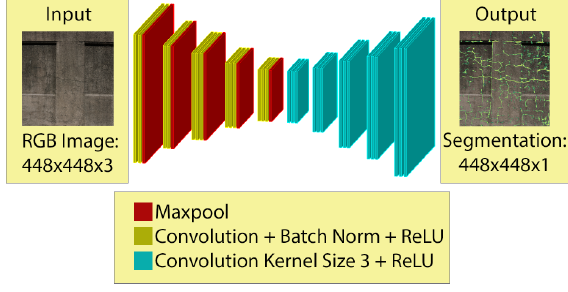
Figure 1. The structure of the proposed CNN model.